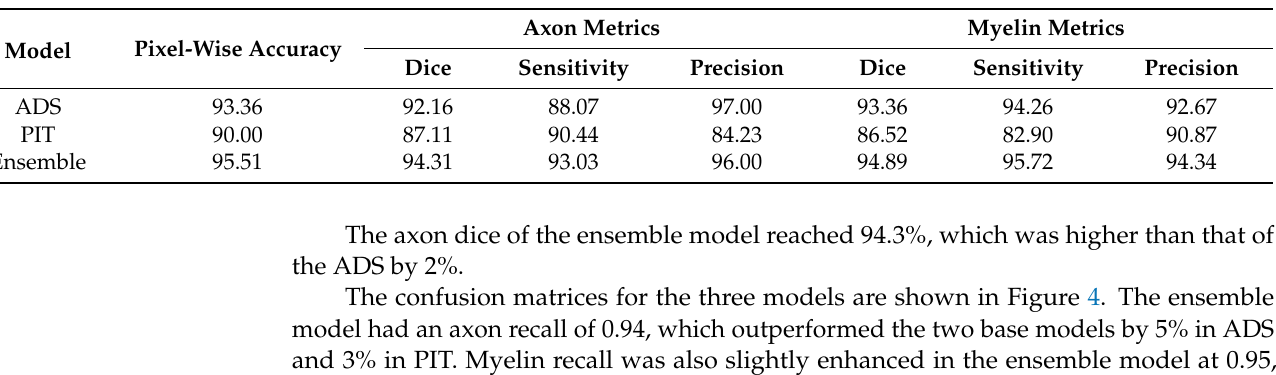
Table 1. Summary of the evaluation metrics calculated from the test images for ADS, PIT, and ensemble models. The results shown are the mean of all of the testing images (24 images).